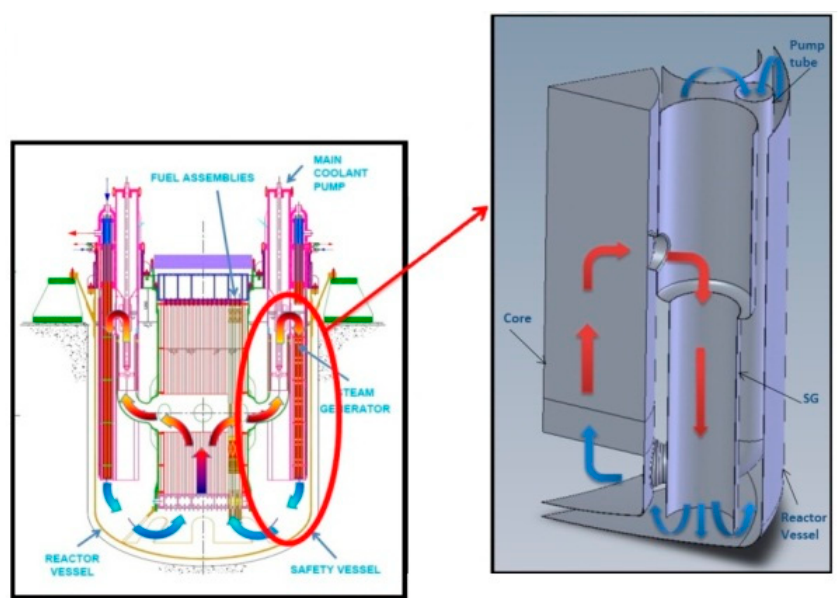
Figure 3. Comparison between the conceptual ( Left ) and the jet pump-based configuration of ALFRED ( Right ).